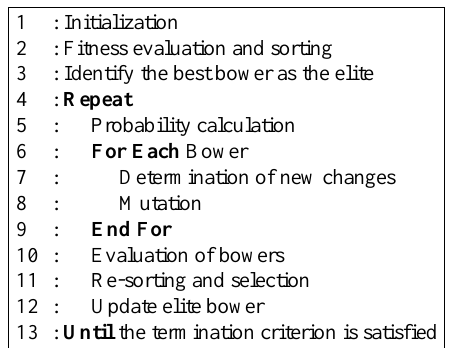
Algorithm 1. Main steps of the SBO